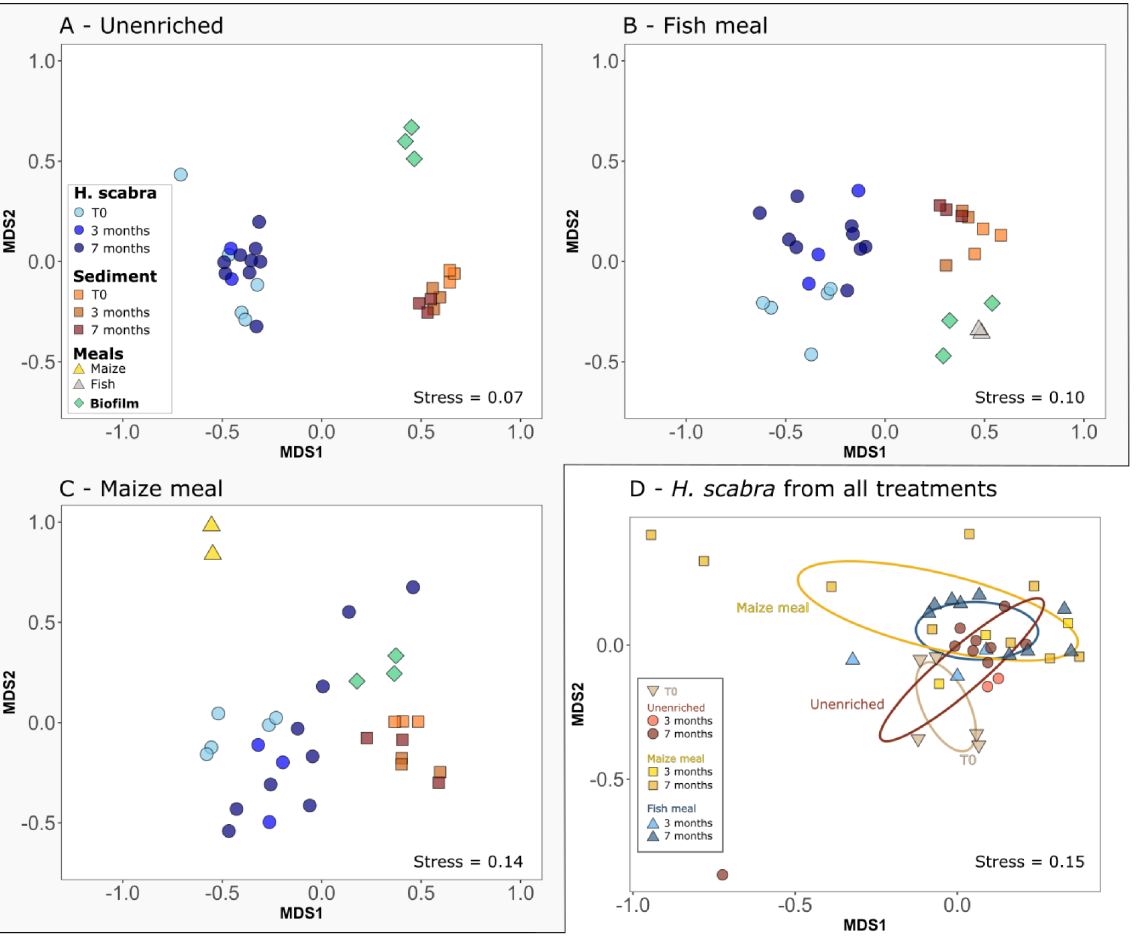
Fig. 2. Multidimensional scaling based on fatty acid composition (mass %) of Holothuria scabra (neutral lipids) and its potential food sources (total lipids); for the unenriched treatment (A), the fi sh meal treatment (B), and the maize meal treatment (C). (D) Represent neutral lipid fatty acids of H. scabra from all treatments and associated ellipses for the different feeding